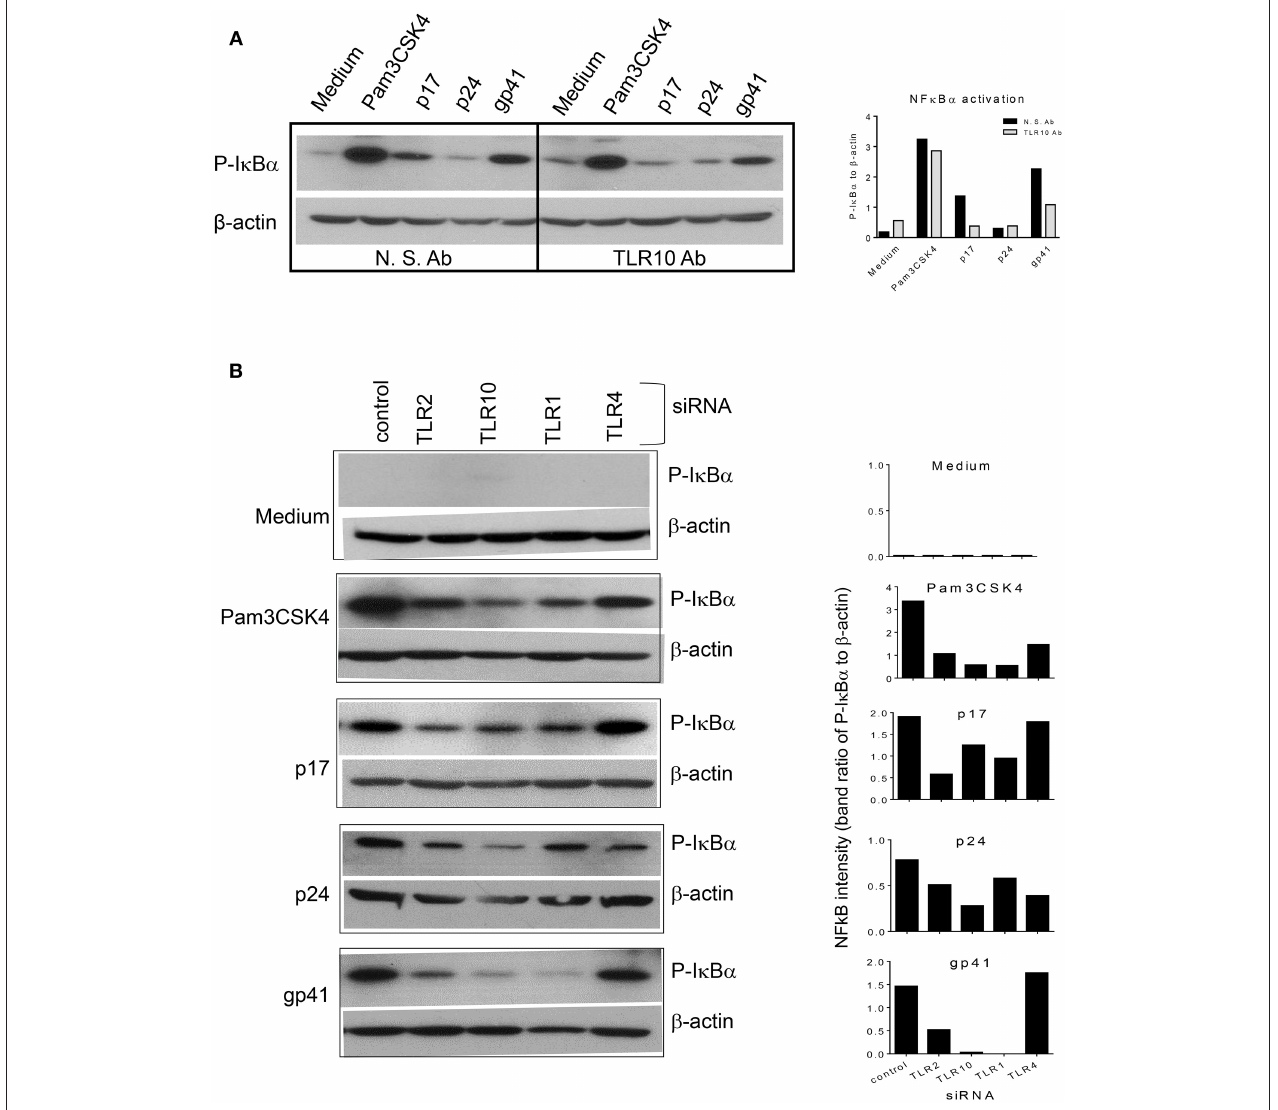
FIGURE 8 | siRNA mediated knockdown or antibody mediated blocking of TLR10 inhibits NF- κ B α activation induced by HIV-1 proteins (A) anti-TLR10 antibody decreased gp41 induced P-I κ B α by half in MCF-10A cells. (B) TLR10 siRNA ablated the induction of P-I κ B α by gp41 in THP-1 cells.